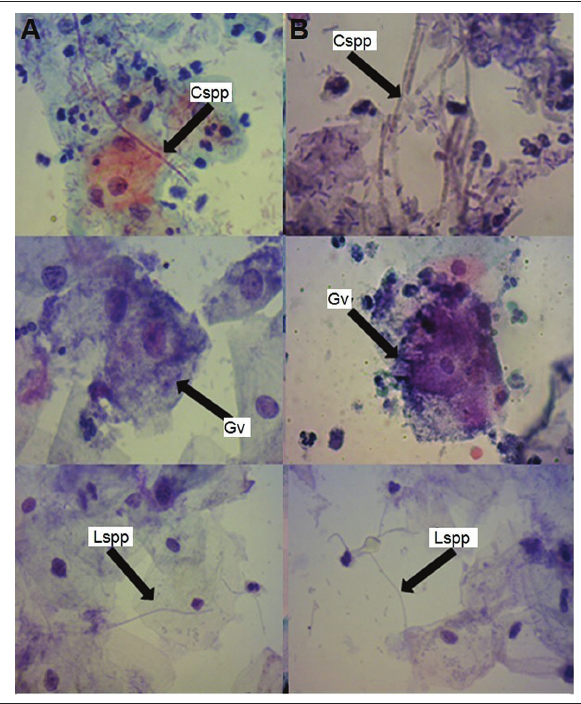
figura 4 − Fotomicrografias de microrganismos observadas em amostras cervicais por exame Papanicolaou (A) e preservadas em FIPLIQ após 15 dias (B). Papanicolaou, 400× FIPLIQ: fosfato de formaldeído-isopropanol; Cspp: Candida spp.; Gv: Gardnerella vaginallis ; Lspp: Leptothrix spp.